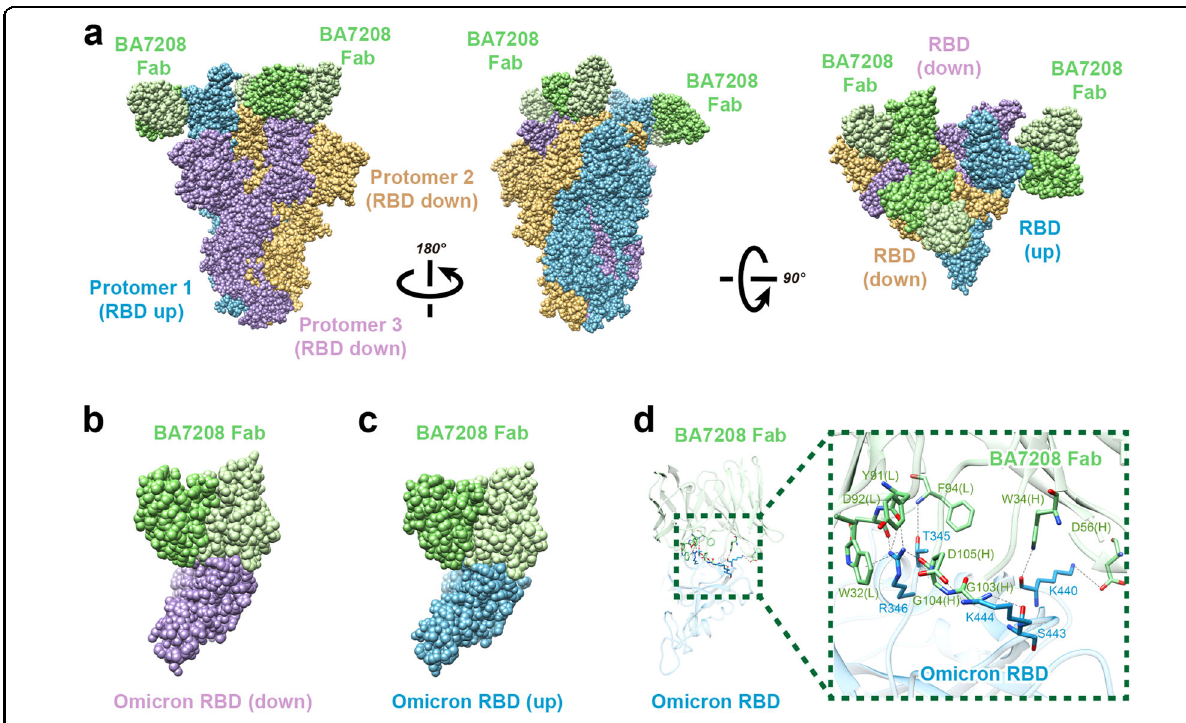
Fig. 4 Cryo-EM of Omicron Spike Trimer with BA7208-Fab. a The complex of three BA7208-Fabs (green) with Omicron Spike Trimer (dodger blue, plum, and rosy brown). b The complex of BA7208-Fab (light green, Fab light chain; dark green, Fab heavy chain) with Omicron Spike-RBD in the down conformation (plum). c The complex of BA7208-Fab with Omicron Spike-RBD in the up conformation (dodger blue). d Zoomed-in views of 7208-Fab binding site on Omicron RBD. Side chain of residues that form the hydrogen bonds, salt bridge, and one cation- π interaction are